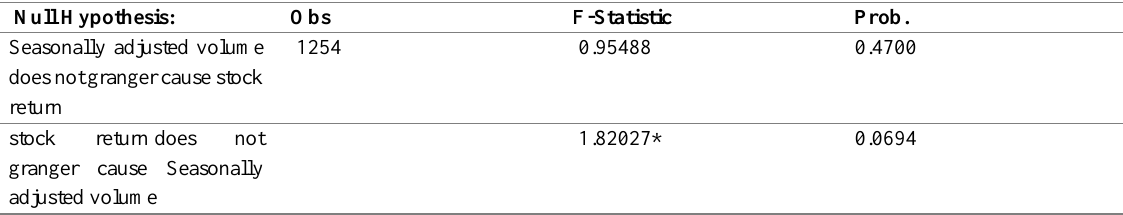
Table 9: Panel Granger causality for Public